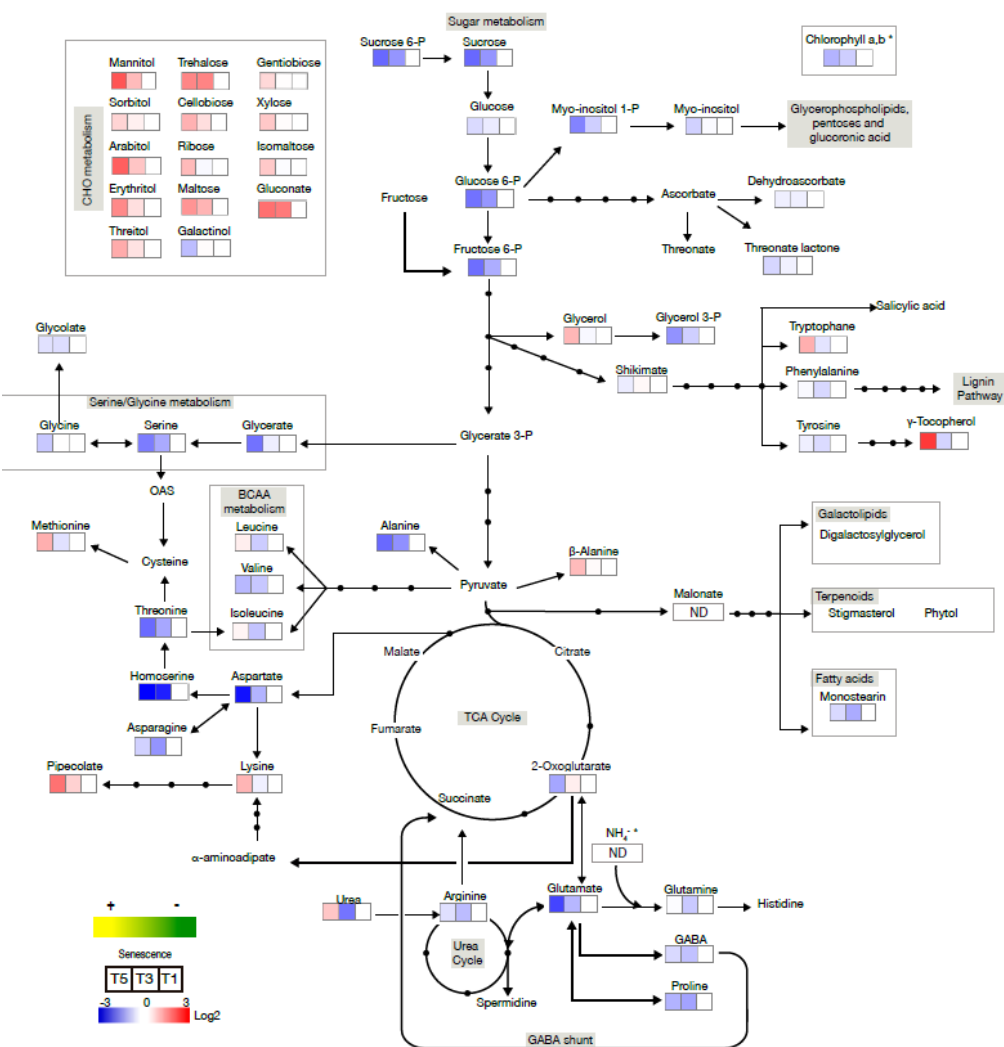
Figure 4. Heat map representation of the metabolite distribution in the three T1, T3 and T5 leaves of barley plants grown in the field. Metabolite concentrations were determined as the peak area in GC-MS analyses normalized to ribitol and to sample mg fresh weight (see Supplementary Data Set 2). The Log 2 of the ratios of the mean of the metabolite contents in each leaf relative to the youngest (T1) leaf were used to represent the metabolite distribution as a heat map. The shades of red or blue colours represent values ranging from − 3 to 3 according to the scale bar. The stage of leaf senescence is schematically indicated by shades of colours from yellow (more senescent old leaf) to green (less senescent young leaf). The Log 2 Fold changes from T1 were calculated on the mean of four biological repeats. Only significant metabolites are presented. Significance was tested using ANOVA and Newman-Keuls (SNK) comparisons.